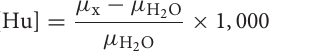
respectively (Nymark and Nasstrom, 1992). So the CT